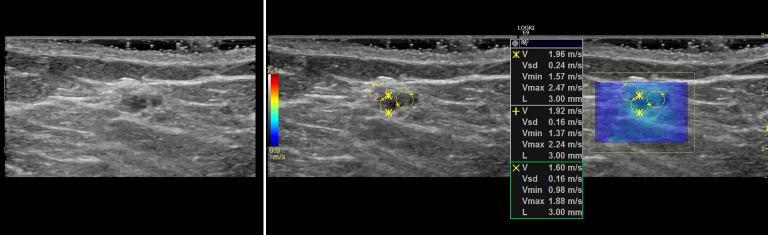
Shear wave speed map of a benign breast mass diagnosed as papilloma.Emean = 10kPa.